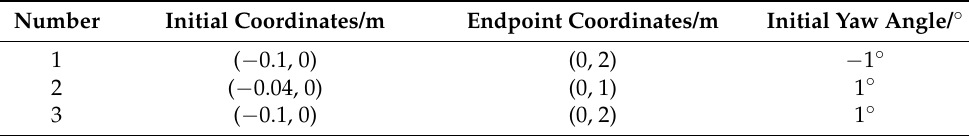
Table 5. The initial conditions for the deviation correction experiment.